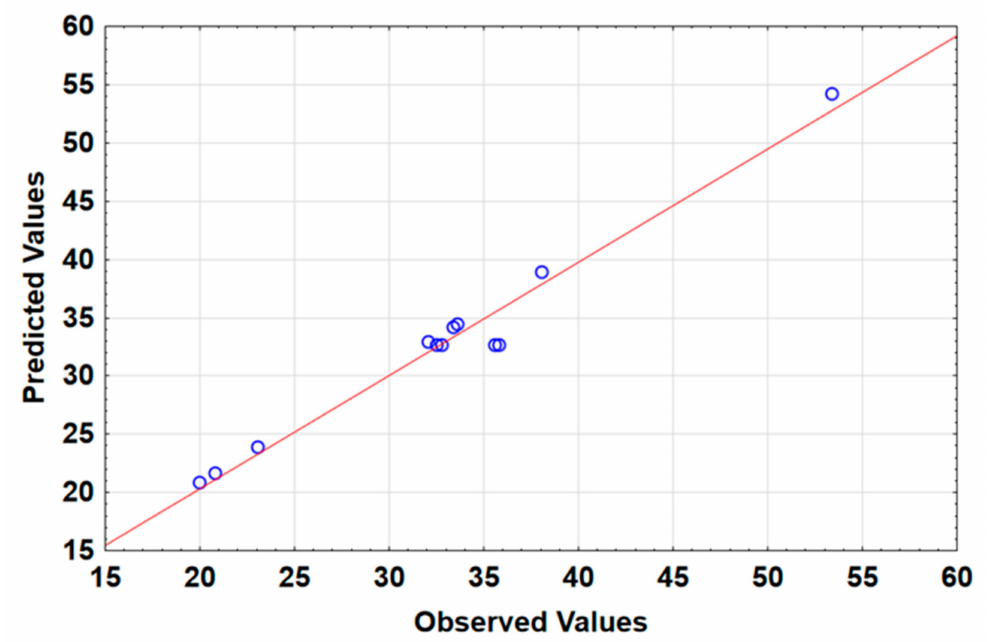
Figure 6. Plot of predicted values versus experimental response